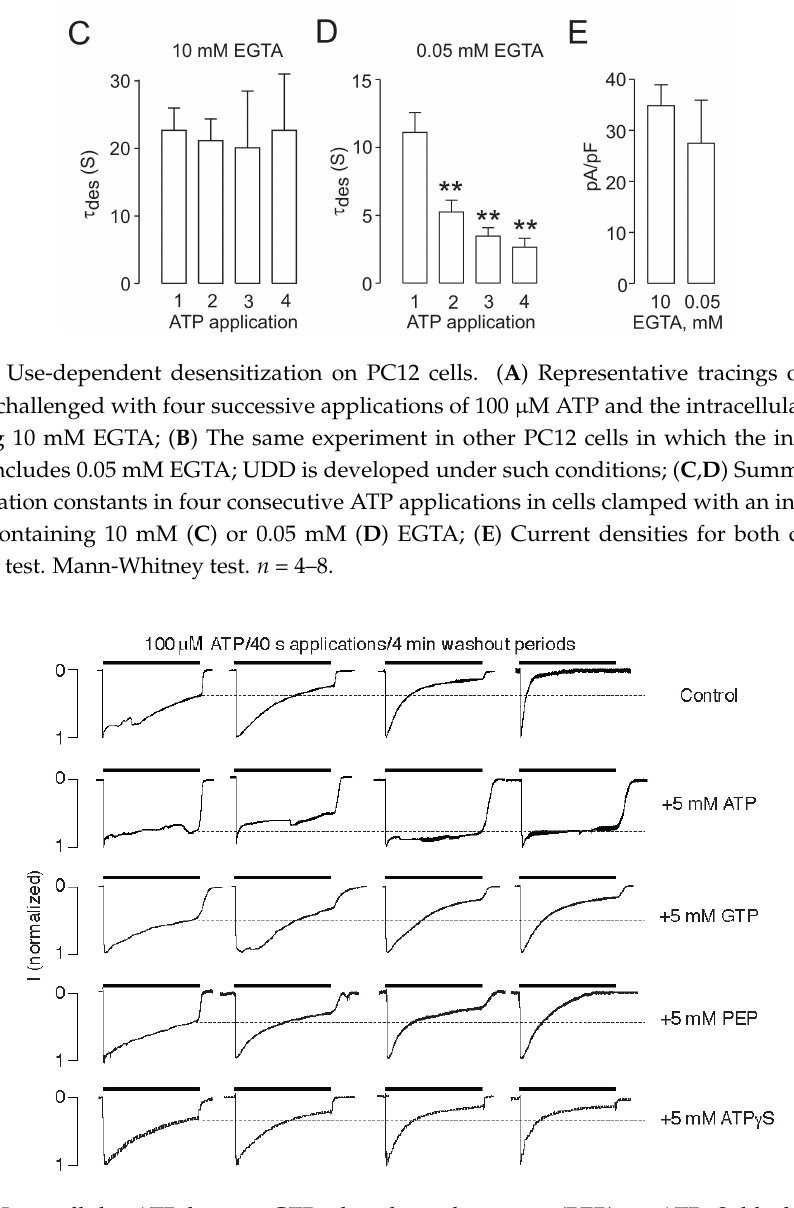
Figure 4. Intracellular ATP, but not GTP, phosphoenolpyruvate (PEP), or ATP γ S, blocks receptor desensitization in the whole-cell recordings performed in HEK293 cells expressing P2X2aR. The cells were dialyzed with ATP, GTP, PEP, or ATP γ S for 7 min before the start of the extracellular ATP application, and the holding potential was − 60 mV. The horizontal dotted lines illustrate the peak in the current response at the end of the first ATP application. Notice that UDD is preserved in all cases except for the cells filled with 5 mM